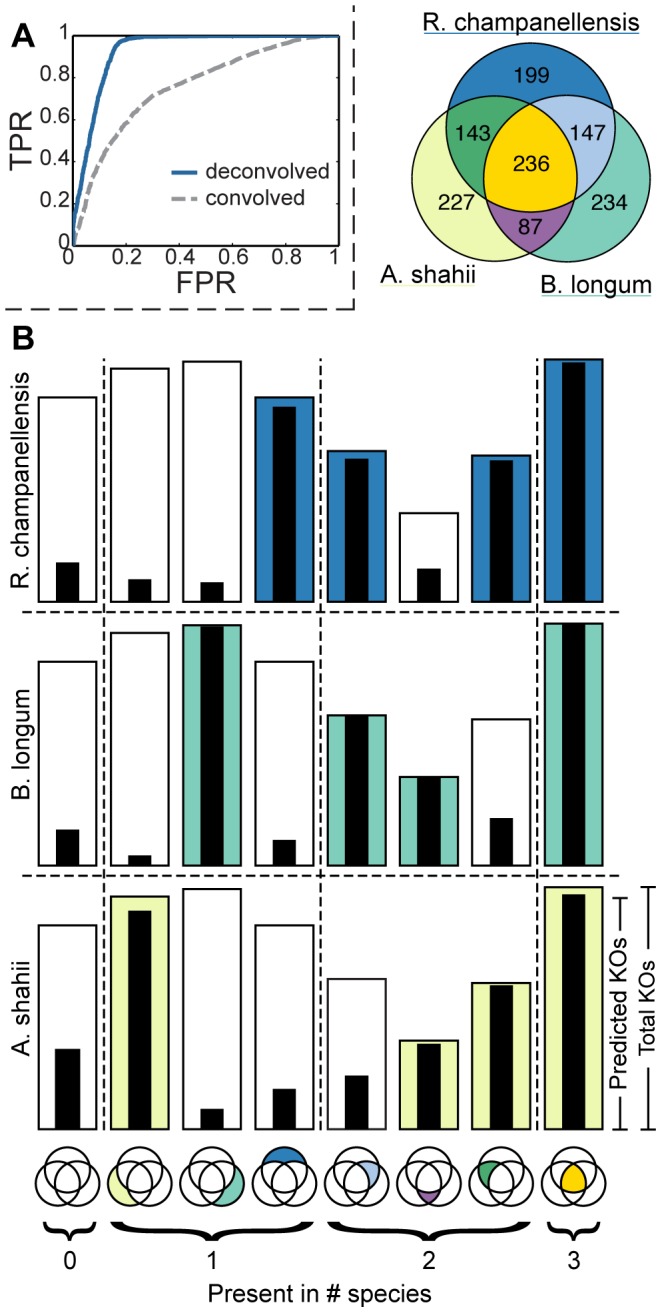
Reconstructing the genomic content of reference genomes from simulated mixed metagenomic samples using metagenomic deconvolution.(A) ROC curves (AUC = 0.93) for predicting KO presence and absence across all species as a function of the threshold used to predict the presence of a KO. ROC curve for a naïve convolved prediction (AUC = 0.76) is illustrated for comparison. (B) Predicted genomic content of each species. KOs are partitioned into bins based on the set of genomes in which they are present (e.g., genes present only in the first species, genes present only in the second species, genes present in the first and second species but not in the third, etc.; see Venn diagram). The height of each bar represents the proportion of KOs in each bin and the color represents the presence of these KO in each species. The black strip inside each bar represents the fraction of KOs from this bin predicted to be present in each species.